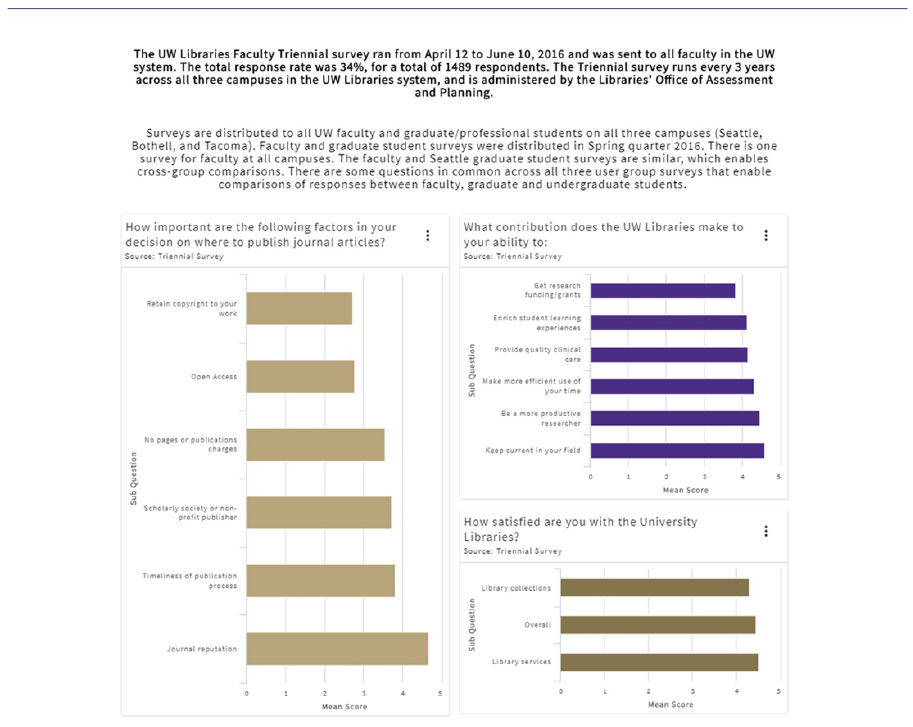
Figure 1 An example story created by a LiveStories client